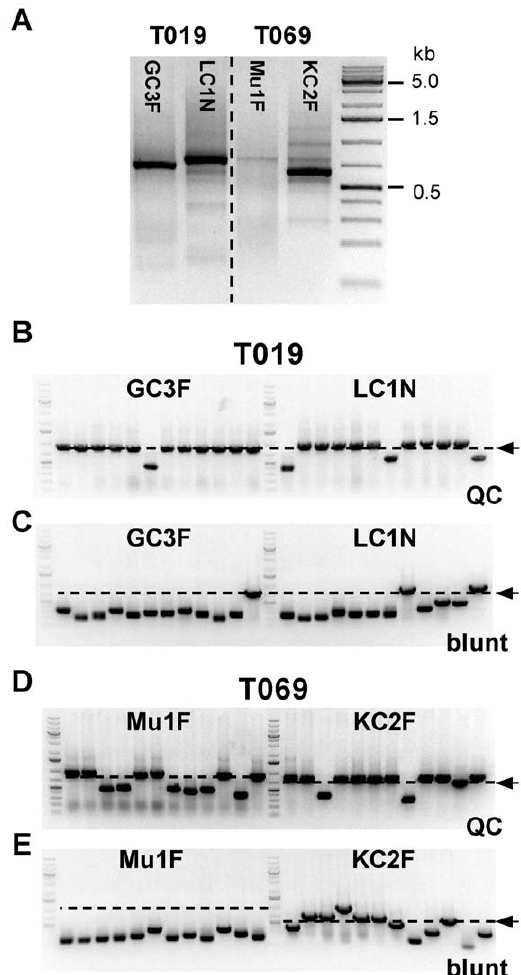
Figure 8. Cloning of Gamma, Mu, Kappa and Lambda immunoglobulin fragments by blunt-end and QC cloning. ( A ) PCR products amplified from G-tailed cDNA prepared from non- Hodgkin lymphoma biopsy sample T019 (isotype Gamma, Lambda) and T069 (isotype Mu, Kappa). Amplification was performed using primer bap2 pc and primers GC3F, LC1N, Mu1F and KC2F as indicated. The PCR products were cloned using QC cloning ( B and D ) or blunt-end cloning ( C and E ). 12 randomly chosen clones for each reaction were analyzed by colony PCR using vector primers. The expected size of full-length inserts is indicated by a dashed line and an